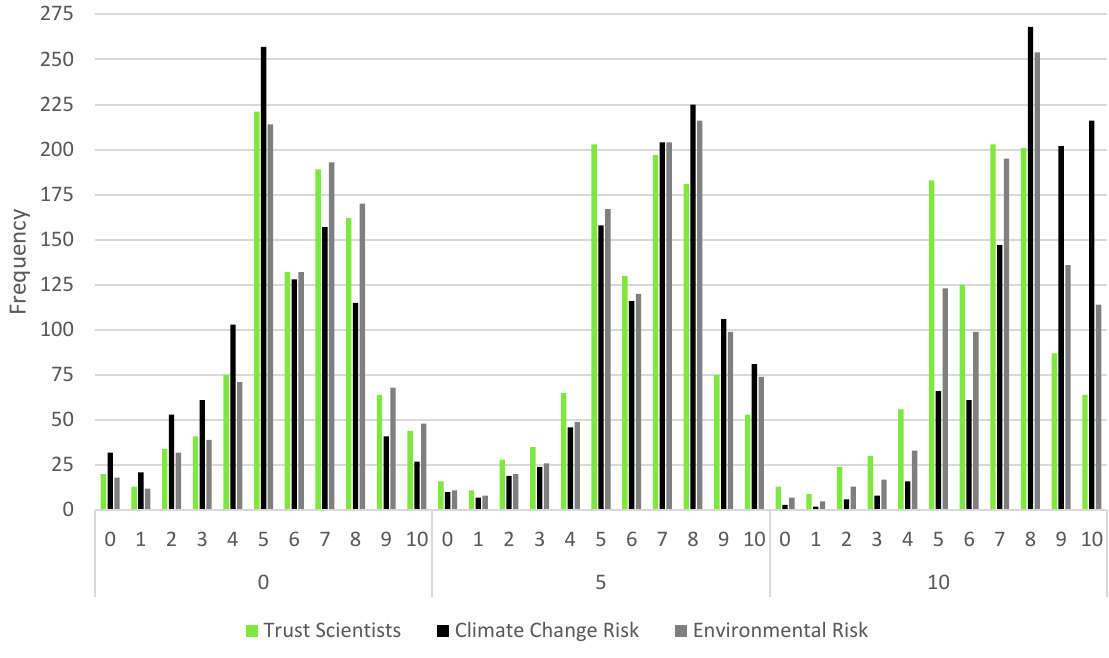
Figure 3. Simulated influence of trust in scientists, climate change risk, and environment risk on health risk perceptions in the world